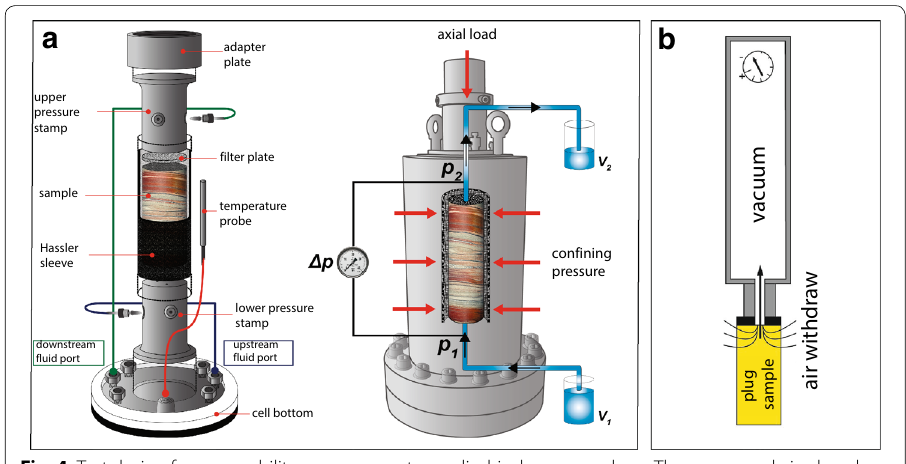
Fig. 4 Test design for permeability measurement on cylindrical core samples. a The core sample is placed between axial pressure stamps and connected to pore fluid pressure pumps establishing vertical flow. The sample is jacketed by a Hassler sleeve in order to separate pore and confining pressure. b Tiny Perm II minipermeameter to determine permeability by applying a vacuum (modified from Filomena et al.